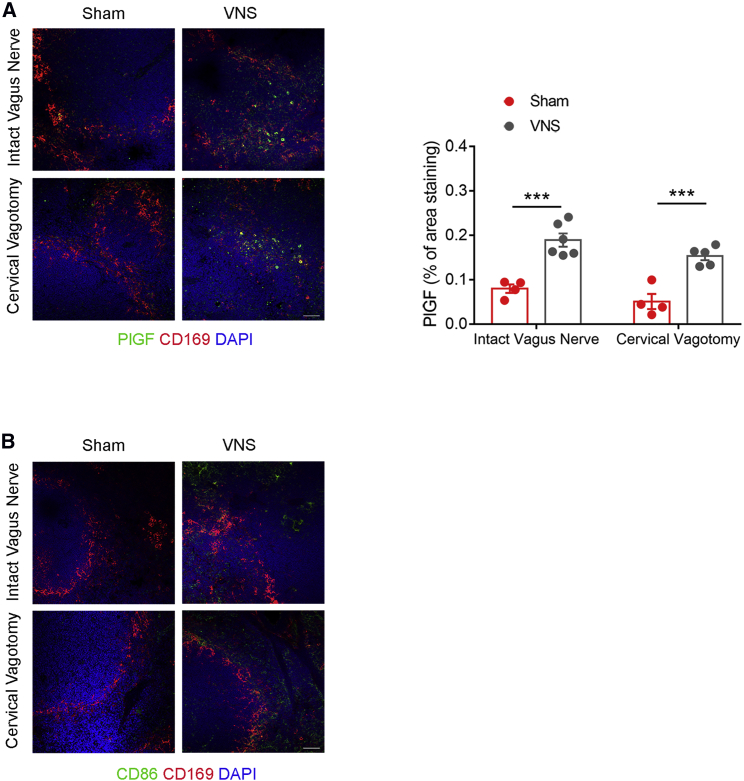
VNS Increases PlGF Expression and CD86 Co-stimulation Factor in the Spleen(A) VNS significant upregulated splenic PlGF expression, measured as the area stained in green, and localized in the marginal zone delimited by CD169-positive macrophages red. The increase of PlGF expression was observed both with intact and resected cervical vagus nerve (intact nerve: sham versus VNS, q(15) = 8.112, ∗∗∗p < 0.001; cervical vagotomy: sham versus VNS, q(15) = 7.322, ∗∗∗p < 0.001). Data were obtained from n = 4 sham intact vagus, n = 6 VNS intact vagus, n = 4 sham cervical vagotomy, and n = 5 VNS cervical vagotomy mice and are presented as mean ± SEM (scale bar, 50 μm).(B) VNS induced the expression of the co-stimulation molecule CD86, stained in green. CD169 marker was used to delineate the marginal zone macrophages in red (scale bar, 50 μm).